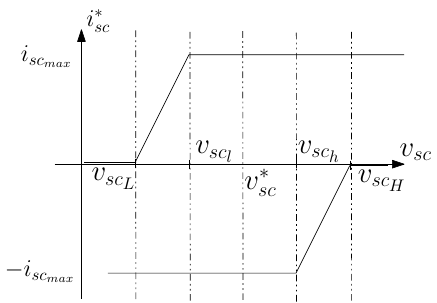
Figure 8. Definition of the maximum SCs current ( i sc